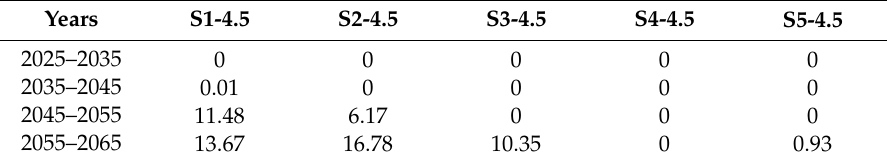
Table 7. Comparison of the sand outflow with respect to sand inflow in percentage.